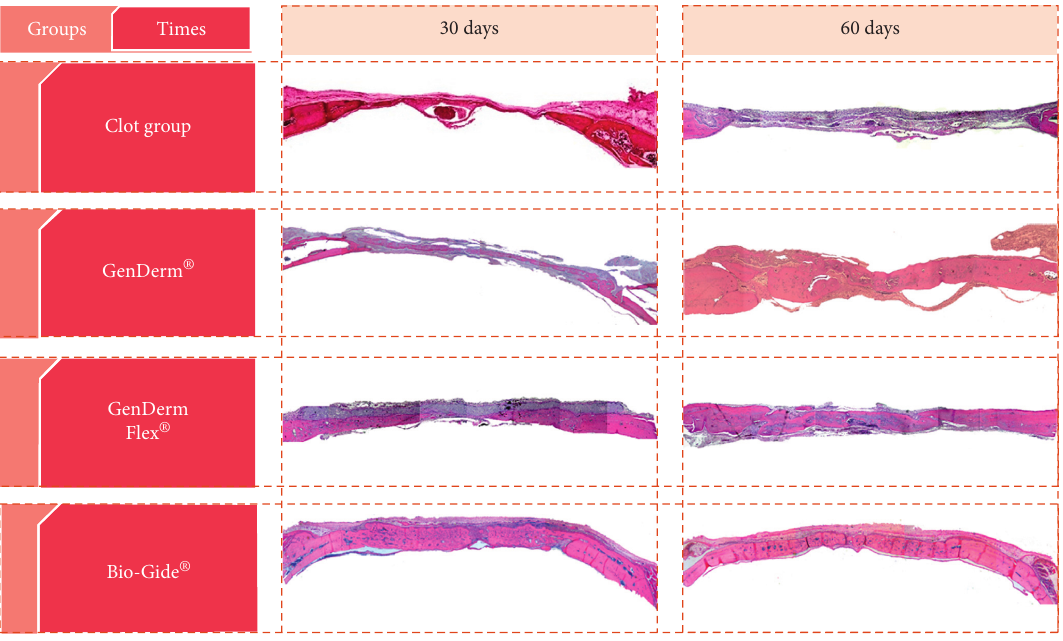
Figure 2: Panoramic histological hematoxylin and eosin-stained sections showing the total area of the groups (C, GD, GDF, and BG). Original magnification, × 6.3.